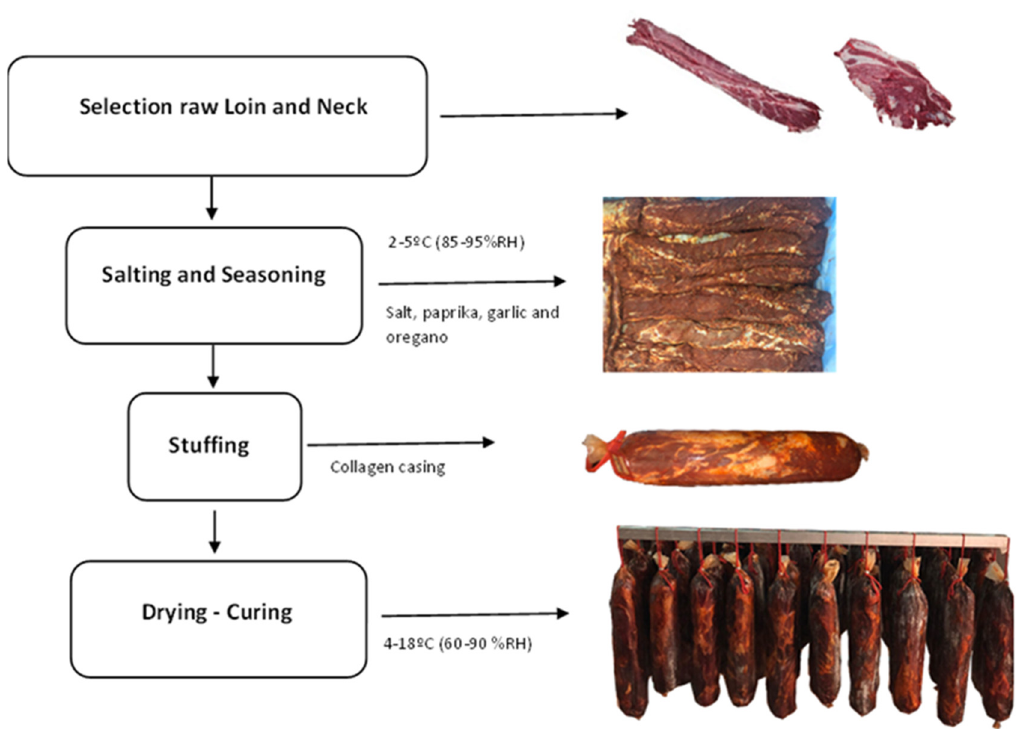
Figure 1. Flow chart of the fabrication of dry-cured loin and “cachaço” of the Bísaro pig (%RH: relative humidity).